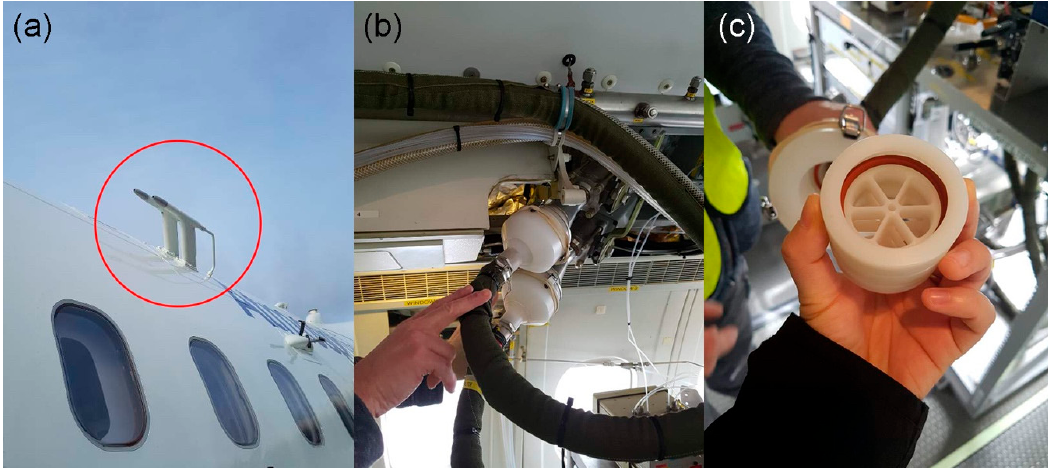
Figure 1. Photo of the Facility for Airborne Atmospheric Measurements (FAAM, UK) research aircraft and the filter collection system. ( a ) Aerosol inlets mounted on the aircraft fuselage. ( b ) Aerosol filter collection system attached to the inlets. ( c ) Filter holder.